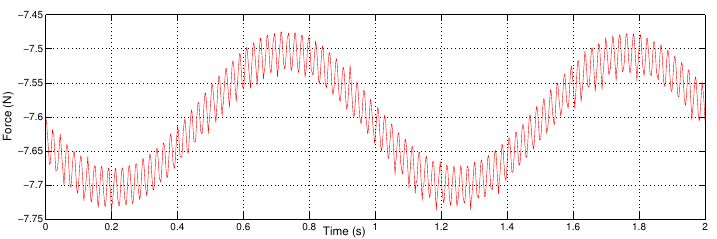
Figure 15. Cutting force along y -direction.